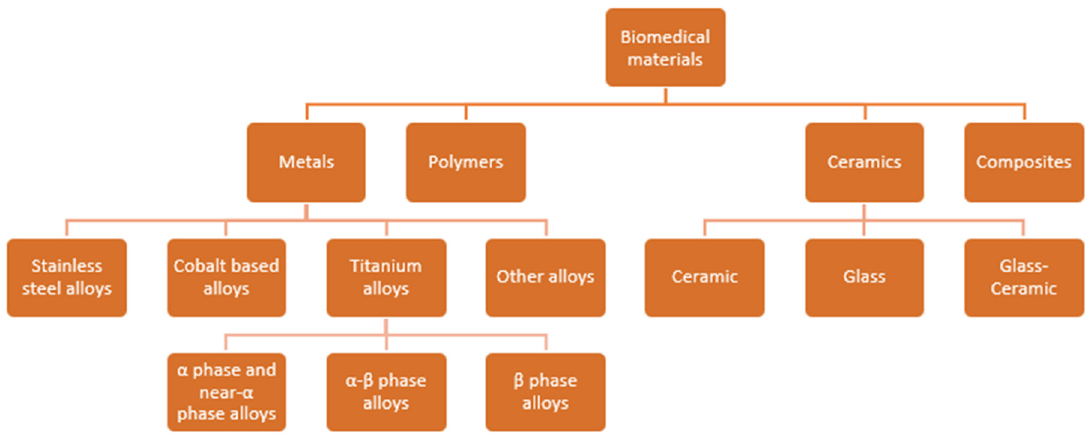
Figure 3. Biomedical materials.